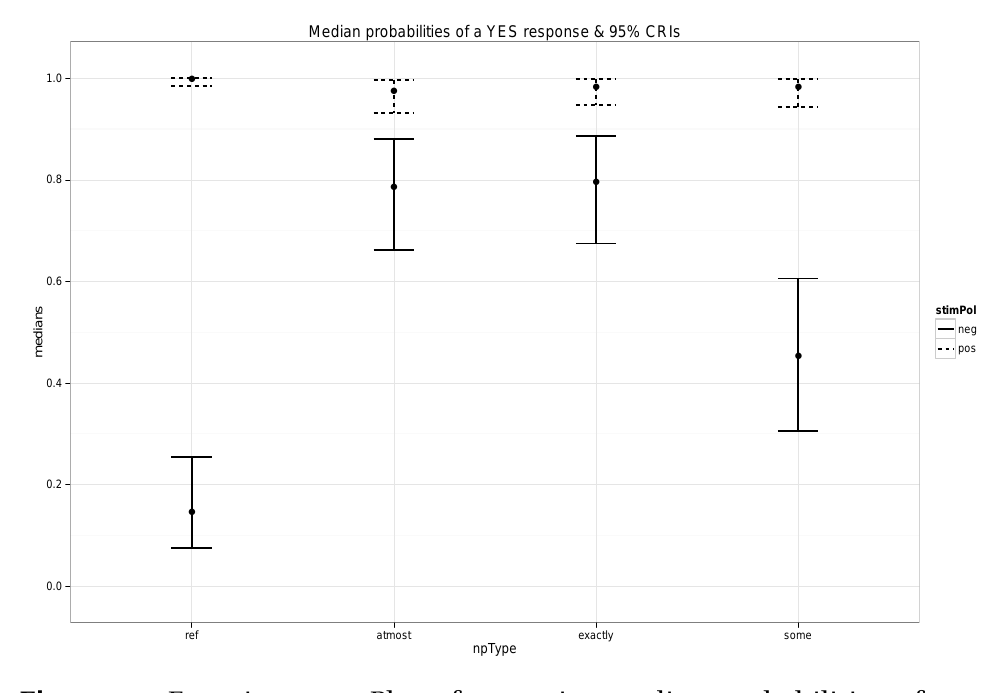
Figure 2 Experiment 1 : Plot of posterior median probabilities of a yes response for the 8 NP type & stimulus polarity combinations and corresponding 95 %